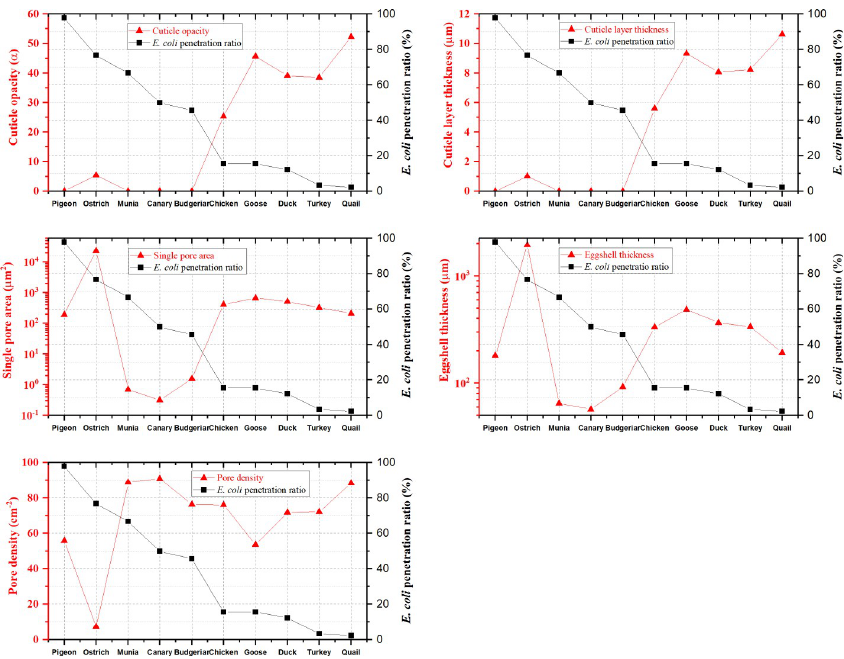
Fig 7. The influence of eggshell traits on E . coli penetration. Since eggshell thickness and pore area showed great variation among the ten bird species’ eggs, those traits are shown on a logarithmic scale. The E . coli penetration rate decreased from pigeon to